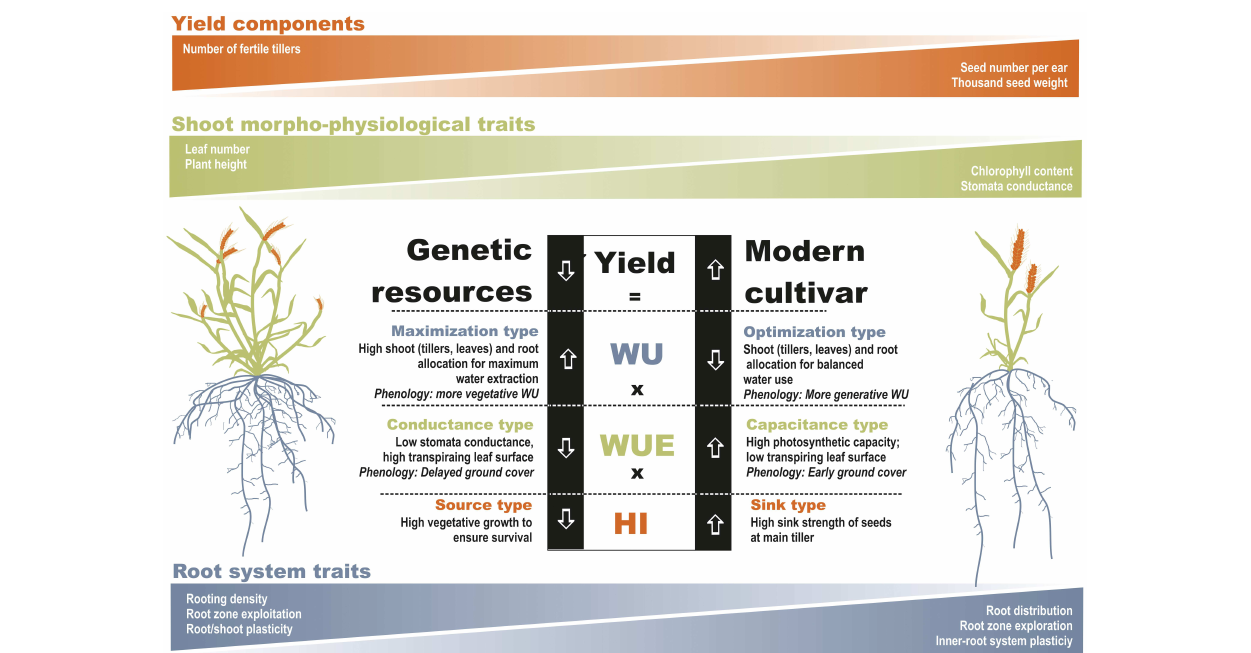
FIGURE 5 | Distinctive behavior of wheat genetic resources and/or underutilized wheat species vs. modern varieties within Passioura’s yield-water framework. (Root trait differentiation is based on Nakhforoosh et al., 2014).